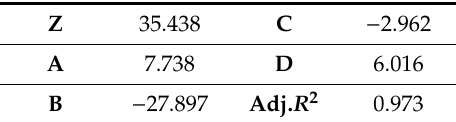
Table 3. Parameters Z, A, B, C, D and adjusted coe ffi cient of determination (Adj. R 2 ) for the fitting curve described by Equation